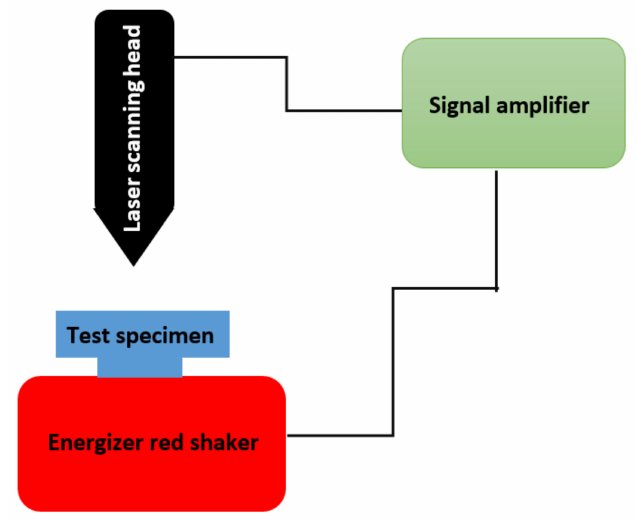
Figure 3. Block diagram of the experimental